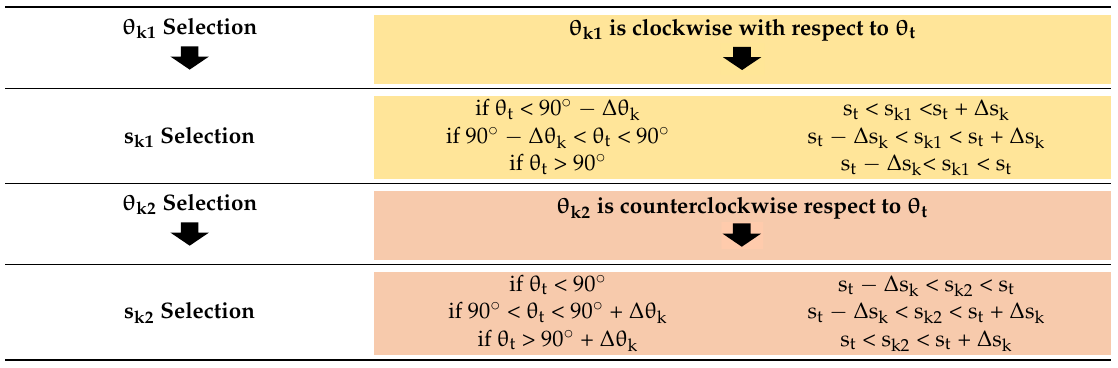
Table 2. Search logic for the Kelvin arms.